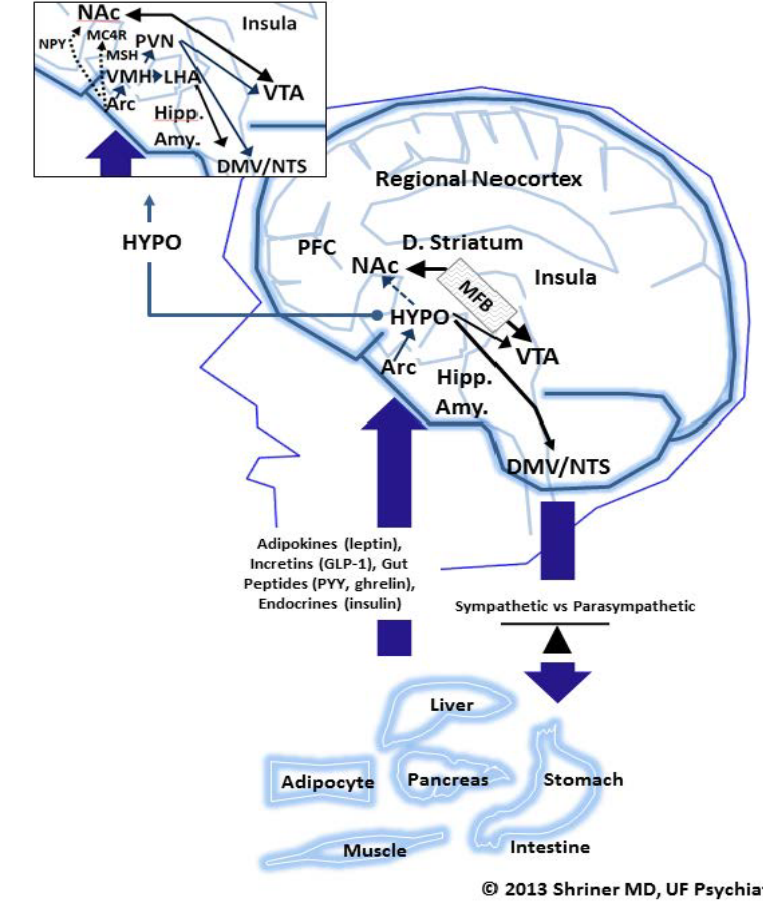
Figure 2. The neurocircuitry of weight. Abbreviations: HYPO (hypothalamus), PFC (Prefrontal Cortex), NAc (nucleus accumbens), D. (dorsal), VTA (ventral tegmental nucleus), Hipp (hippocampus), Amy (amygdala), Arc (arcuate nucleus), DMV (dorsal motor nucleus of vagus), NTS (dorsal motor nucleus of vagus), NPY (neuropeptide Y), MC4R (melanocortin receptor 4), PVN (paraventricular nucleus), VMH (ventromedial hypothalamus), MSH (melanocortin stimulating hormone), LHA (lateral